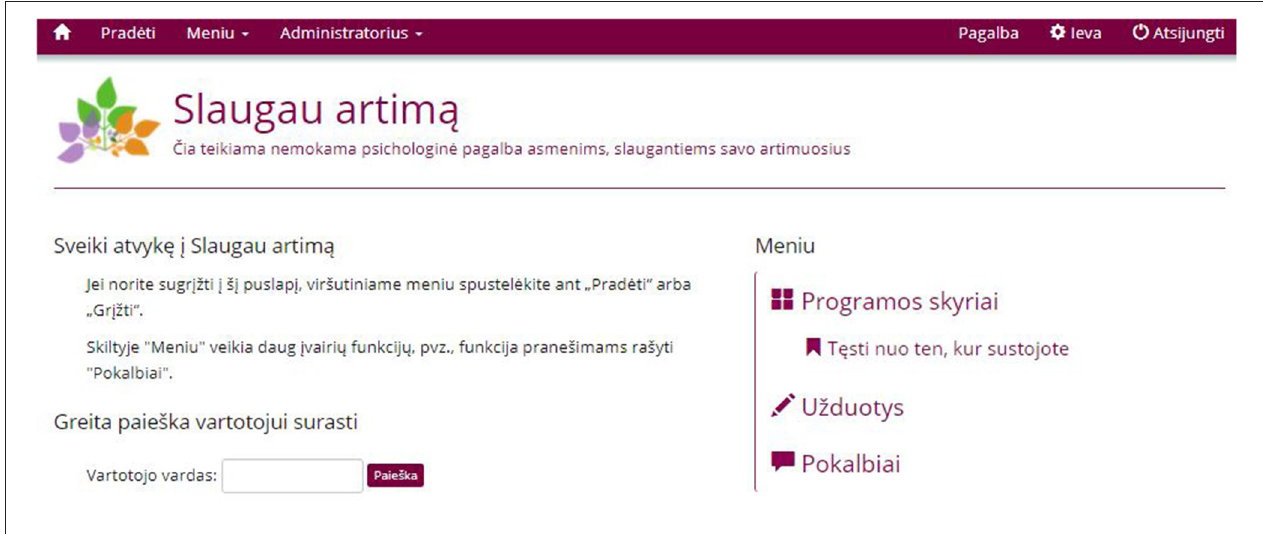
FIGURE 2 | User screen after logging in. On the right-side of the screen users can click on the Programos skyriai to access different modules, click on Užduotys to access exercises or start a conversation with a psycholigst by clicking on Pokalbiai .